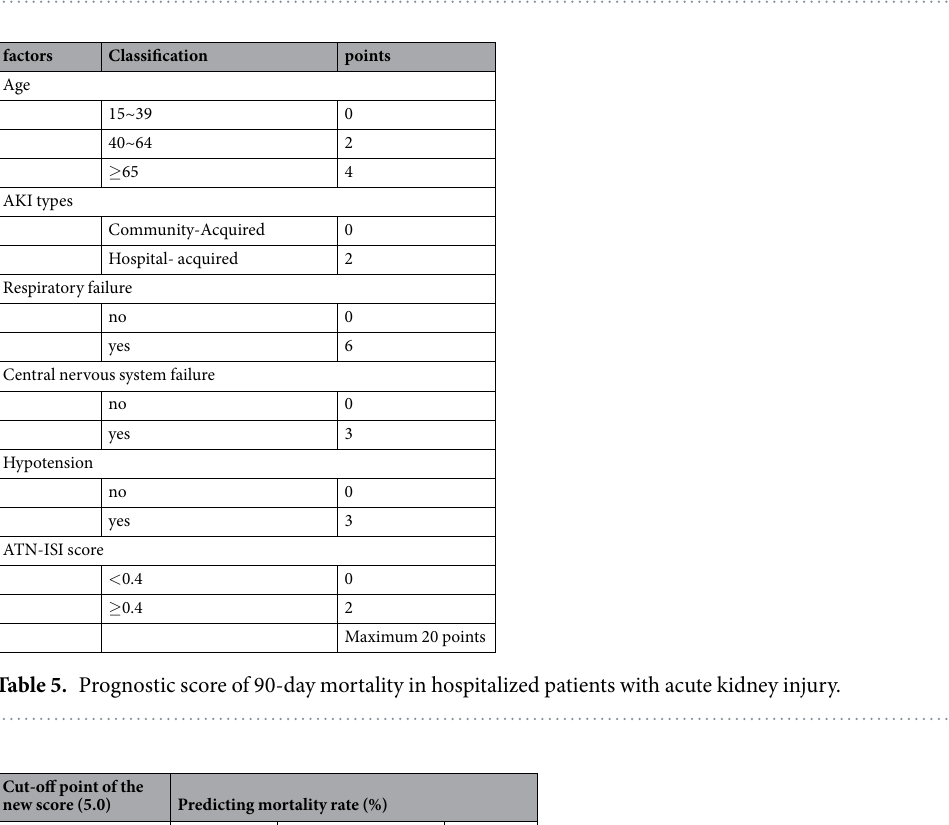
Cut-off point of the new score (5.0)